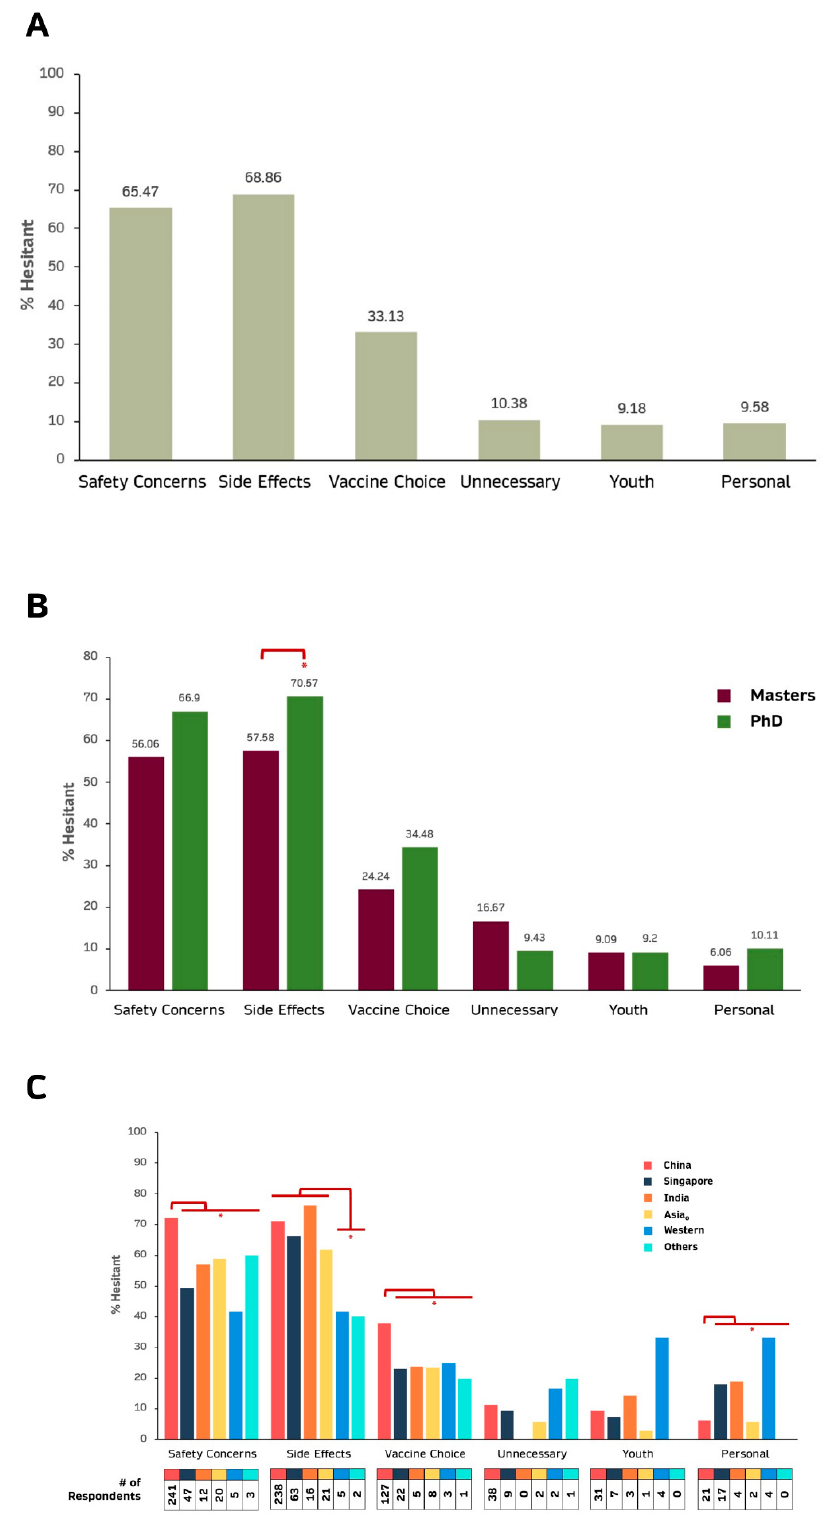
Figure 3. Reasons for being hesitant about COVID-19 vaccination among hesitant respondents. ( A ) Overall. ( B ) Programme types; ( C ) Citizenship (See Table S2 for the specific countries for Asia o , Western and Others). * adjusted p < 0.05.